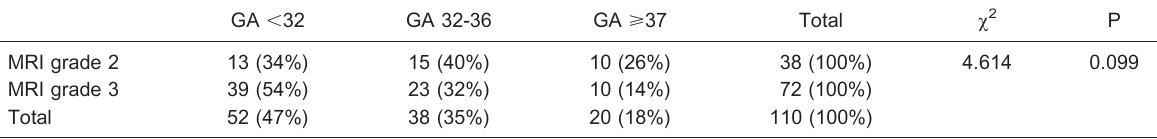
Table 5. Magnetic resonance imaging findings according to the gestational age of children with hypoxic-ischemic